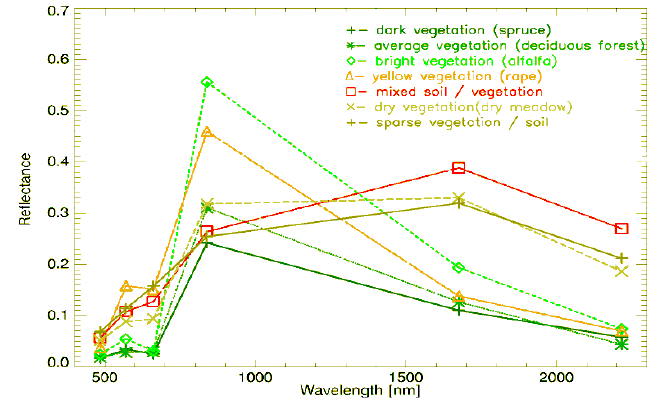
Figure 2. Template vegetation spectra used in SPECL and typical vegetation types falling into the respective class (in